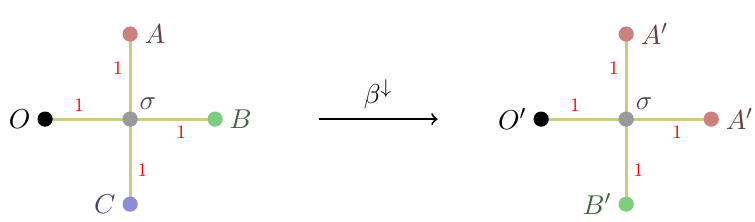
Figure 7. The coarse-graining (5.10) of the perfect state graph model f G 3 from fig.